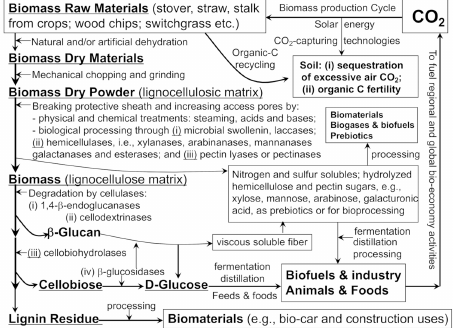
Figure 1. An illustration of the major processes and biological steps in utilization and conversion of agricultural waste feedstock biomass in providing sustainable functional foods and food animal production and renewable lignocellulosic ethanol, functional soluble fiber and other biomaterials with an emphasis on the essential roles of biomass-degrading enzymes as novel industrial